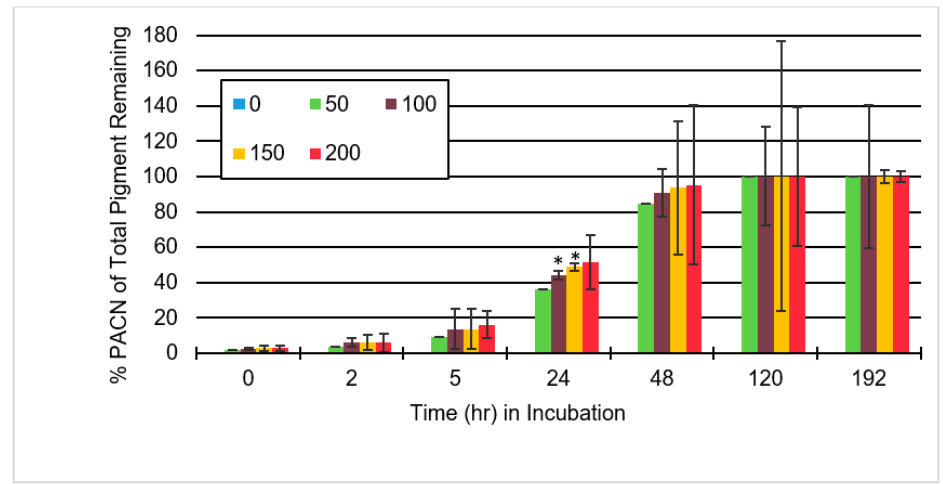
Figure 6. Average total pyranoanthocyanin (PACN) as part of total pigment after time in incubation at 65 °C with samples containing anthocyanin to caffeic acid molar ratios of 1:0, 1:50, 1:100, 1:150, and 1:200. Error bars represent the standard deviations. Significant difference from anthocyanin to caffeic acid molar ratio of 1:50 for the same incubation time with * p < 0.05.